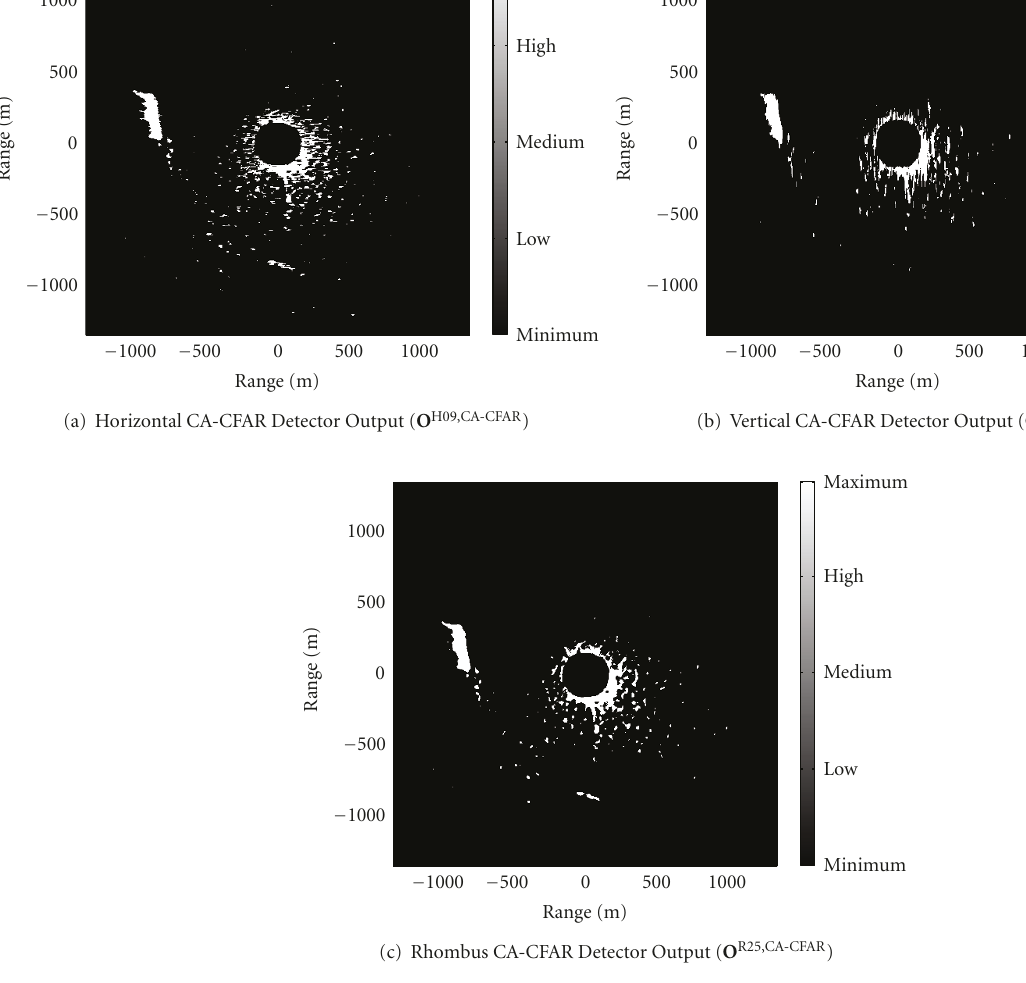
be considered like a grainy and spread remanent clutter. This e ff ect is due to the wave field propagating from right to left in the radar